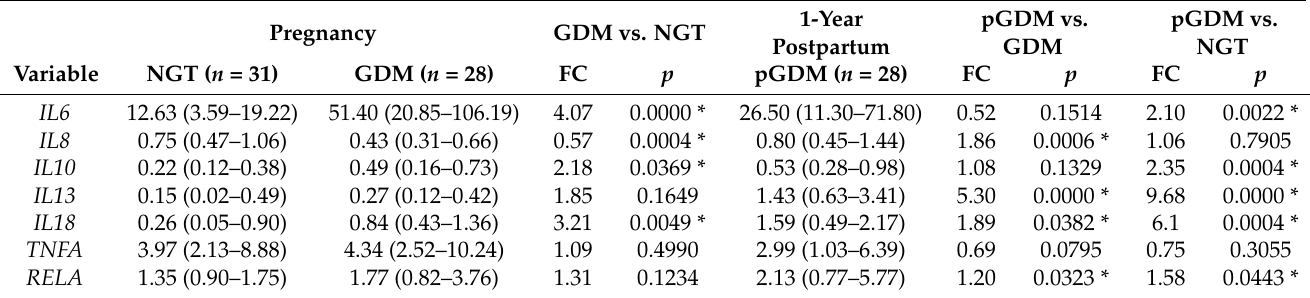
Table 2. Relative mRNA expression and fold changes (FC) of individual genes in leukocytes of women during and after